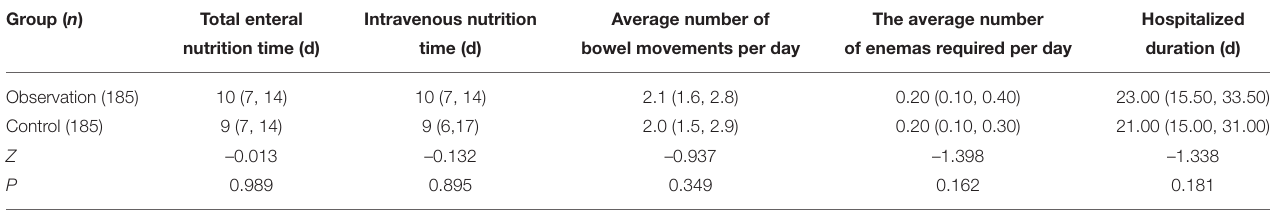
TABLE 6 | Comparison of the incidence and composition of parenteral nutrition(PN)-related diseases in the two groups of premature infants during neonatal intensive care unit (NICU) hospitalization. Group ( n ) NEC* Cholestasis PNAC*